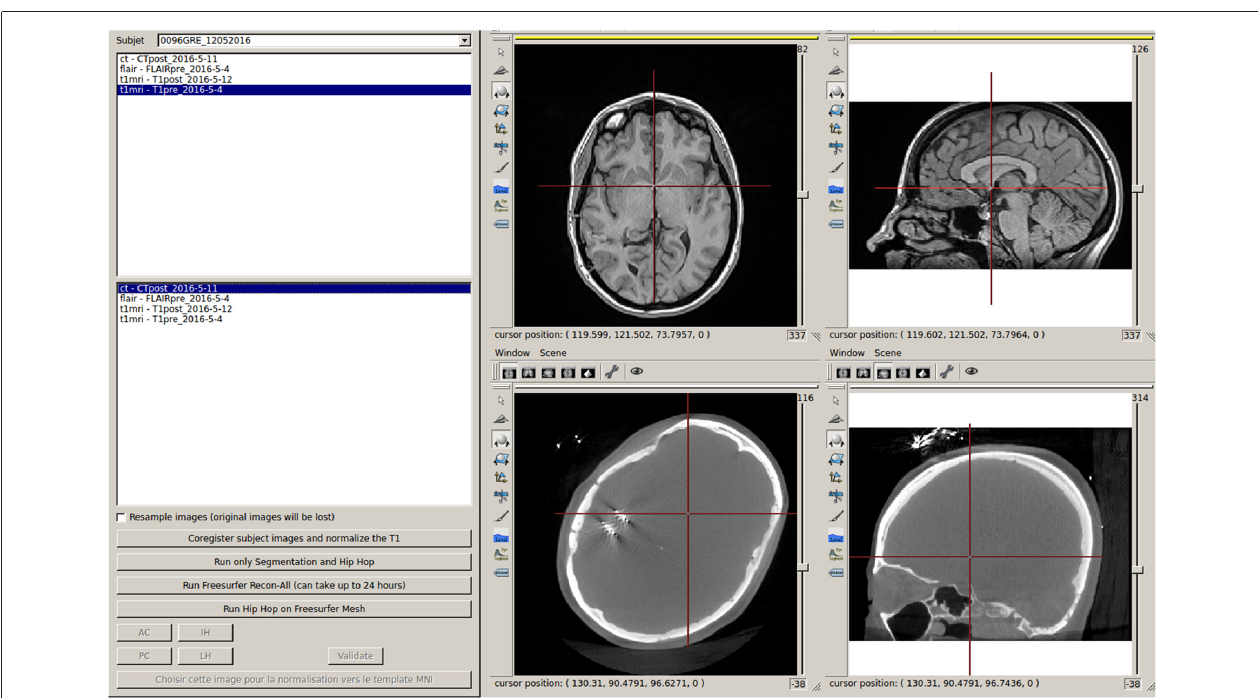
FIGURE 3 | Interface to run the coregistration between imported images and to start MarsAtlas parcellation, Freesurfer recon-all process and MarsAtlas parcellation from Freesurfer gray/white meshes.